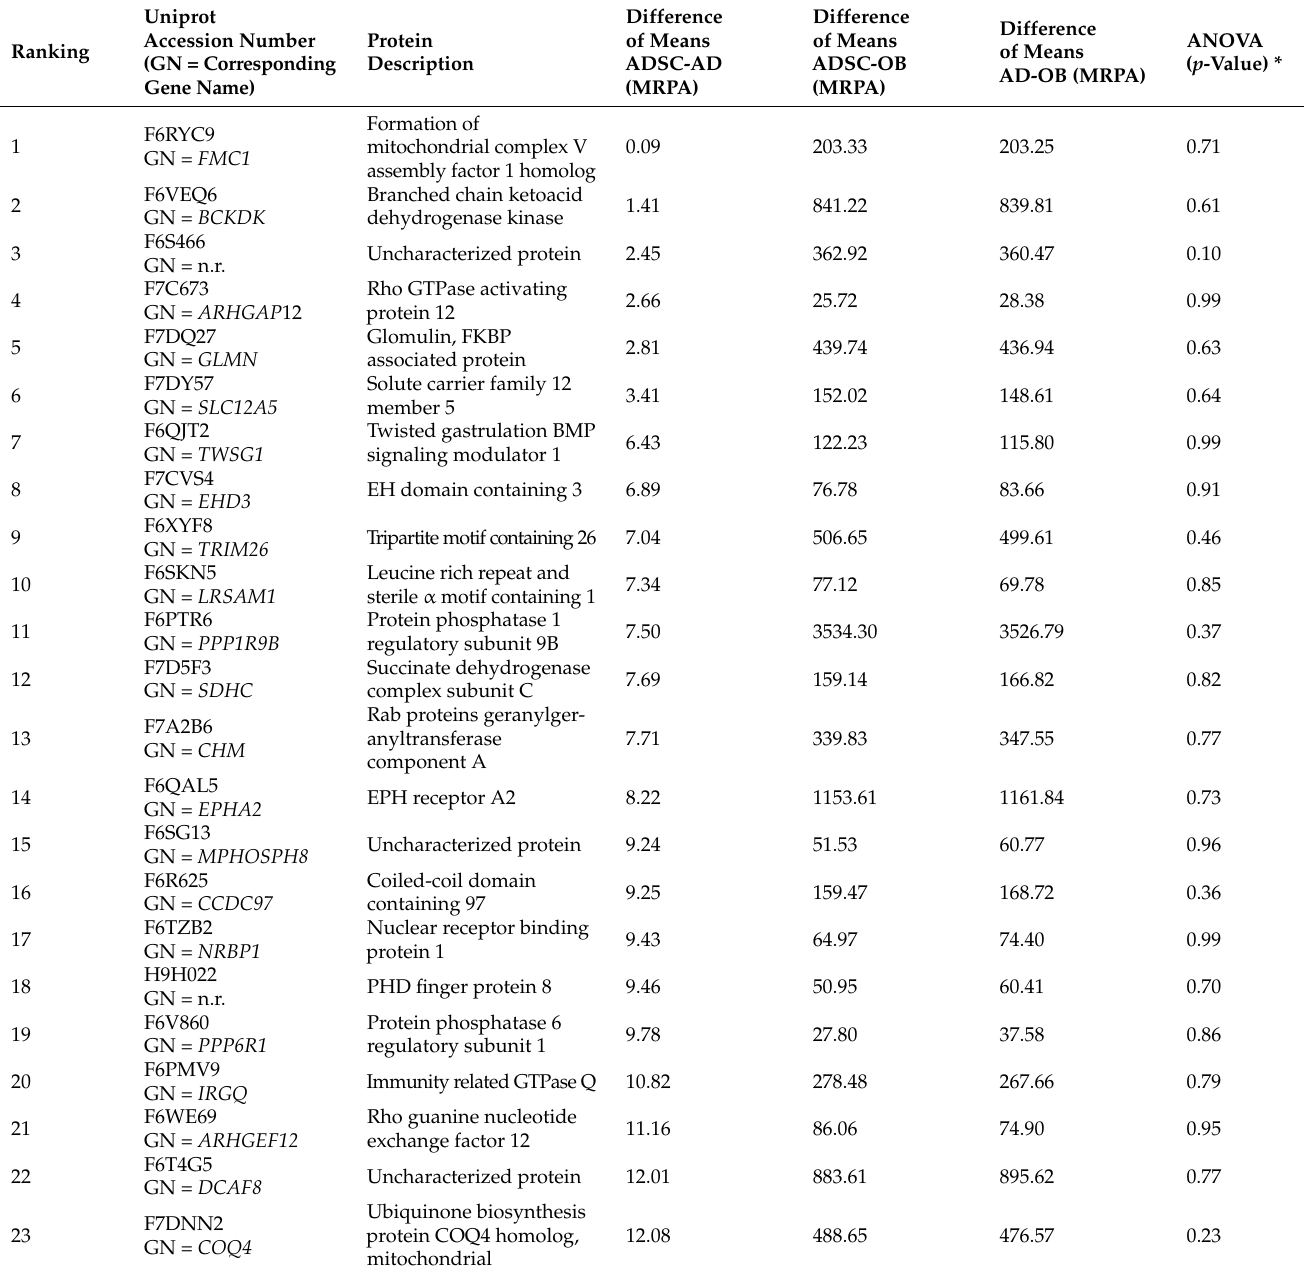
Table 2. Ranking of proteins by smallest difference of means between the ADSCs and ADs; the difference between the means for the ADM–SM and ADM–OB conditions are reported, and the p -values as determined by ANOVA. MPRA = mean relative protein